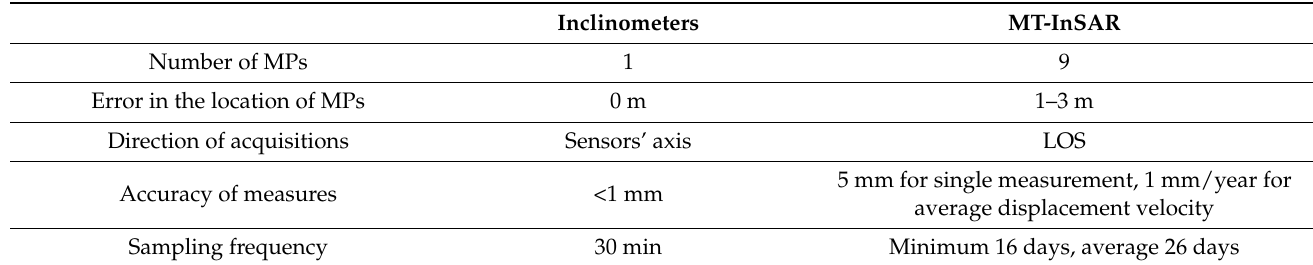
Table 2. Errors and characteristics of both acquisition systems in this case